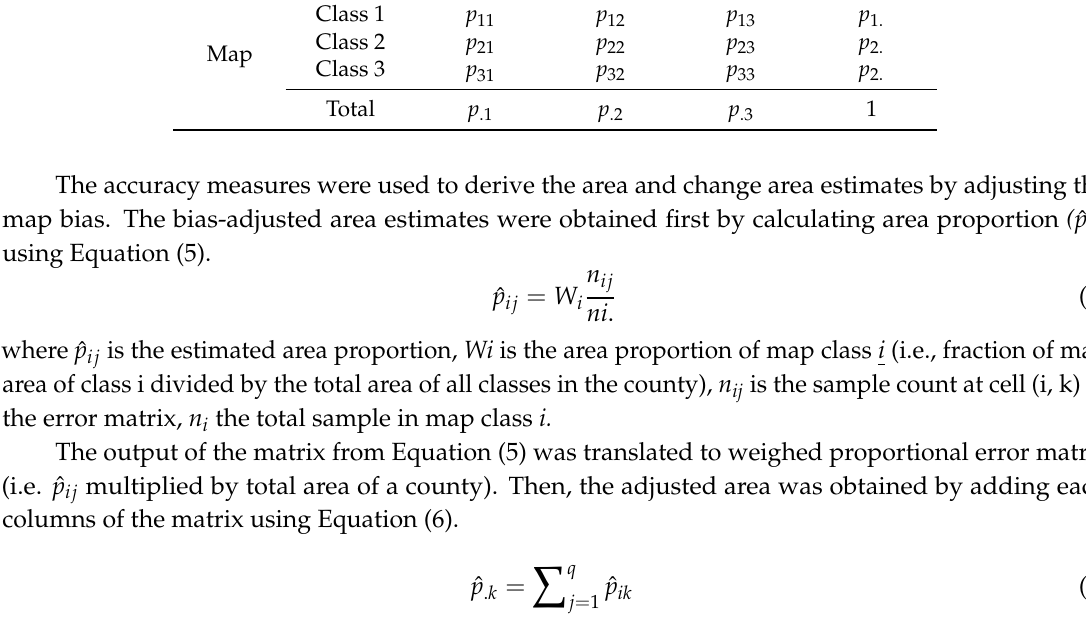
Table 2. An example of error matrix as depicted in [44] With p represent the cell entries of population error matrix for land cover classes (i.e., 3 in this case) expressed as proportion of area Reference Class 1 Class 2 Class 3 Total Class 1 p 11 p 12 p 13 p 1. Class 2 p 21 p 22 p 23 p 2. Map Class 3 p 31 p 32 p 33 p 2. Total p .1 p .2 p .3